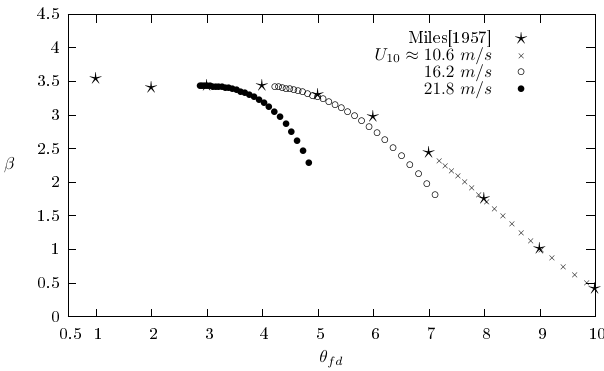
Fig. 5. Same as Fig. 4 with h = 18